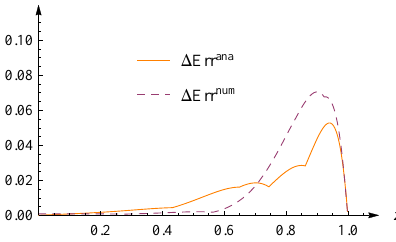
Figure 4. Total absolute errors for analytic approximate solutions ( ∆ Err ana ) and numerical solutions ( ∆ Err num ) from three field